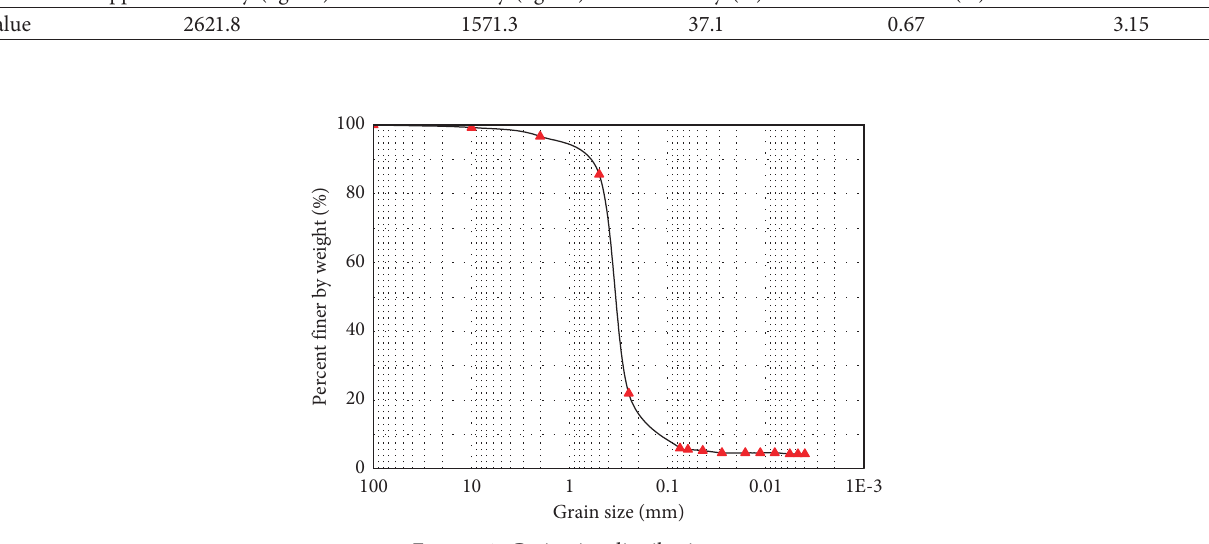
Figure 1: Grain size distribution curve. Table 2: Particle composition and related indices of the back-filled sand.